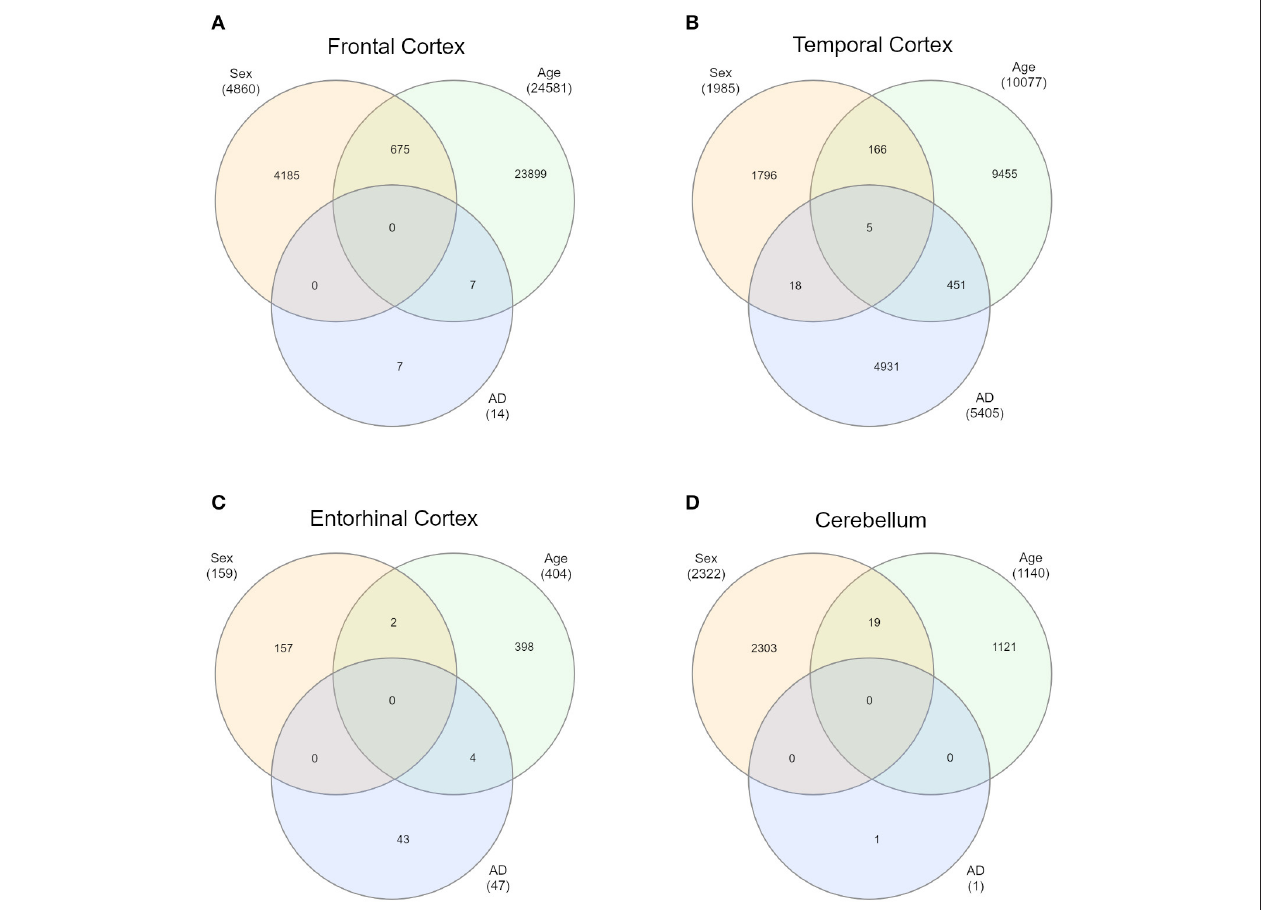
FIGURE 4 | Intersections of sex-, age-, and AD-associated probes in each of the four brain regions. Venn diagrams depict the intersection between sDMPs, aDMPs, and AD-DMPs in FC (A) , TC (B) , ERC (C) , and CRB (D) .